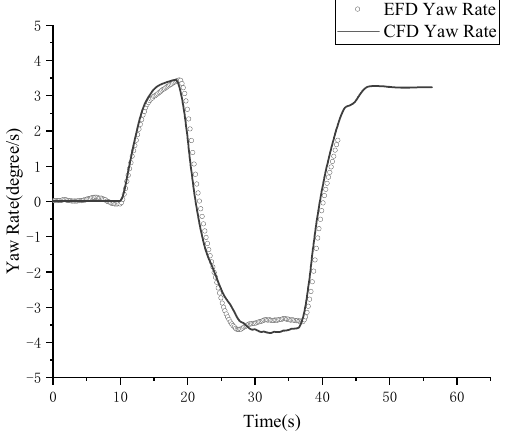
Figure 29. Yaw rate in 20 ◦ zigzag maneuver.